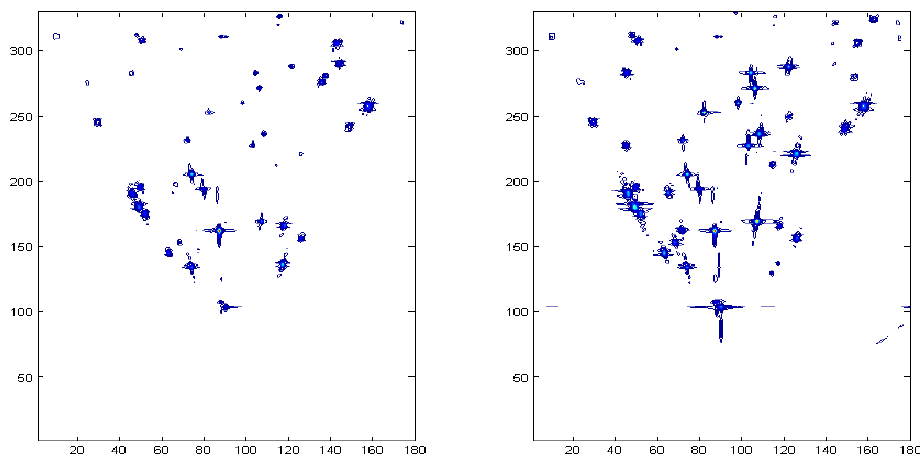
Fig. 8. Comparative images for two-channel radar with continuous-waveform